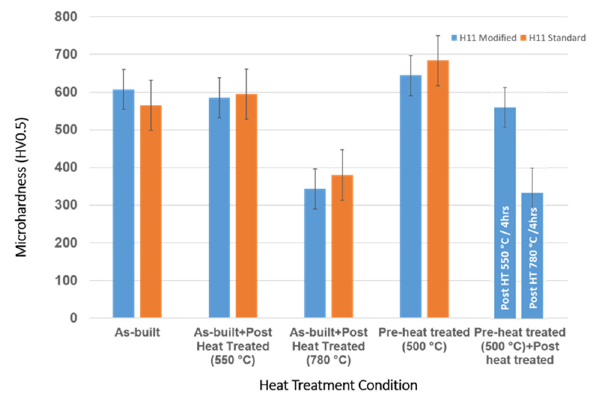
Figure 10. The microhardness graph of the standard and modified 1.2343: the as-built, as-built + 550 °C or 780 °C/4 h post heated, preheat treated, preheat treated (500 °C) + 550 °C or 780 °C/4 h post heated.